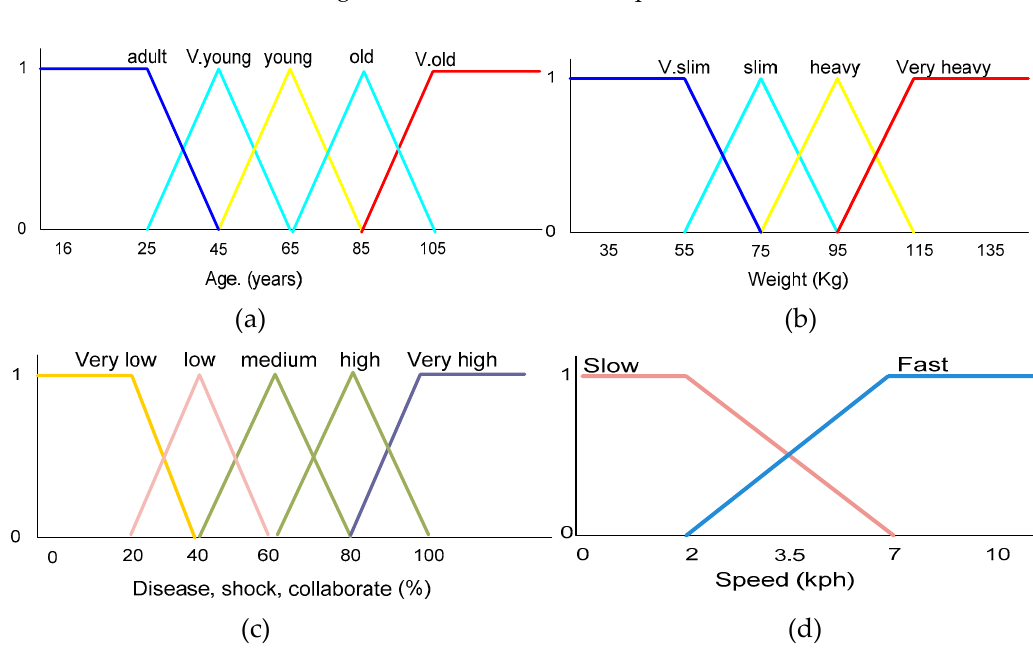
Figure 1. Model definition: ( a ) age membership function; ( b ) weight membership function; ( c ) fisease, shock, collaborate membership function; ( d ) speed membership function [12].